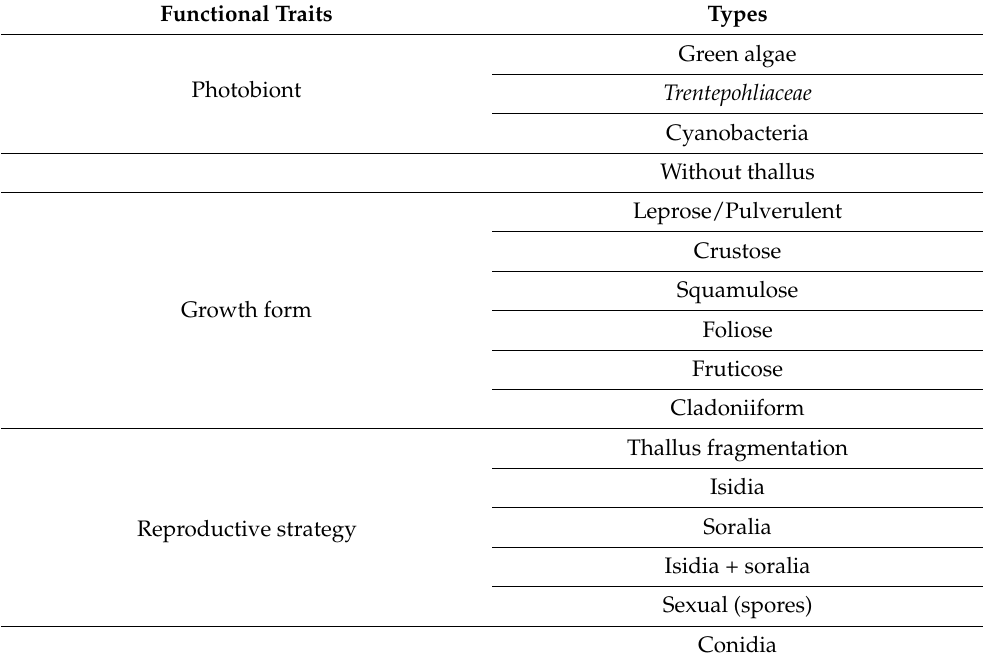
Table 2. Functional traits: Photobiont, growth form, and reproductive